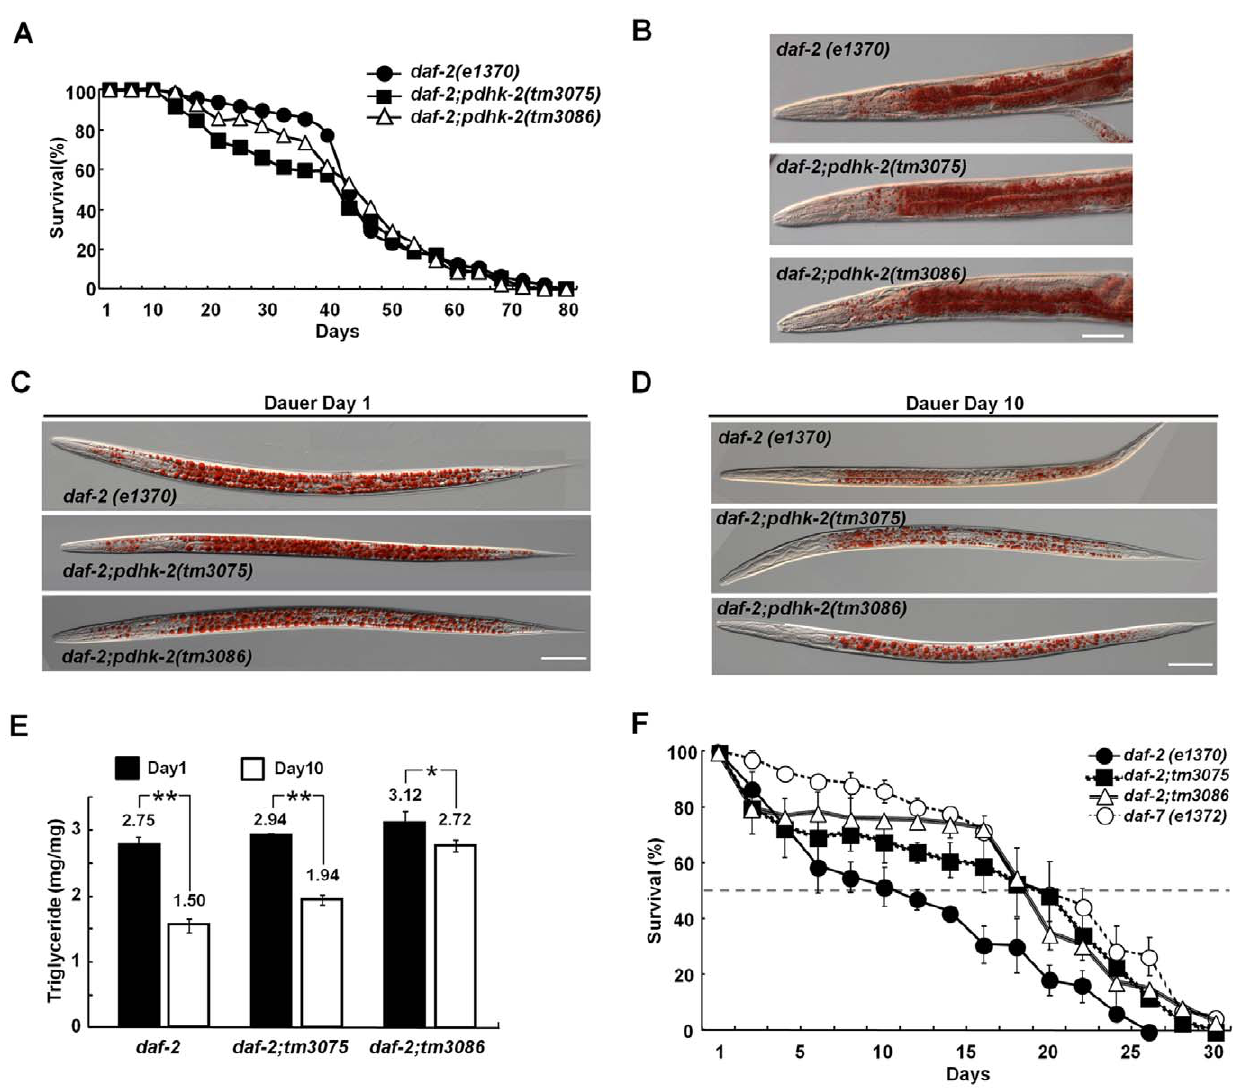
Figure 3. Functions of PDHK-2 in the dauer state. ( A ) Lifespan analysis of daf-2(e1370) , daf-2(e1370) ; pdhk-2(tm3075) , and daf-2(e1370);pdhk- 2(tm3086) mutant worms. ( B ) Oil Red O staining of daf-2(e1370) , daf-2(e1370) ; pdhk-2(tm3075) , and daf-2(e1370);pdhk-2(tm3086) worms at the day 1 adult stage. ( C ) Oil Red O staining of daf-2(e1370) , daf-2(e1370) ; pdhk-2(tm3075) , and daf-2(e1370);pdhk-2(tm3086) worms at the day 1 dauer stage. ( D ) Oil Red O staining of daf-2(e1370) , daf-2(e1370) ; pdhk-2(tm3075) , and daf-2(e1370);pdhk-2(tm3086) worms at the day 10 dauer stage. ( E ) TG content in daf-2(e1370) , daf-2(e1370) ; pdhk-2(tm3075) , and daf-2(e1370);pdhk-2(tm3086) worms at day 1 and day 10 of the dauer stage. The values represent means [ 6 SDs] from three independent experiments. * p , 0.05 and ** p , 0.001 compared with the control ( F ) Dauer survival assays performed on daf- 2(e1370) , daf-2(e1370) ; pdhk-2(tm3075) , daf-2(e1370);pdhk-2(tm3086) , and daf-7(e1372) mutant worms. Dauer worms were obtained from synchronized L1 stage worms after 60 hours at 25 u C. The values represent means [ 6 SDs] from five independent experiments. Scale bar: 50 m